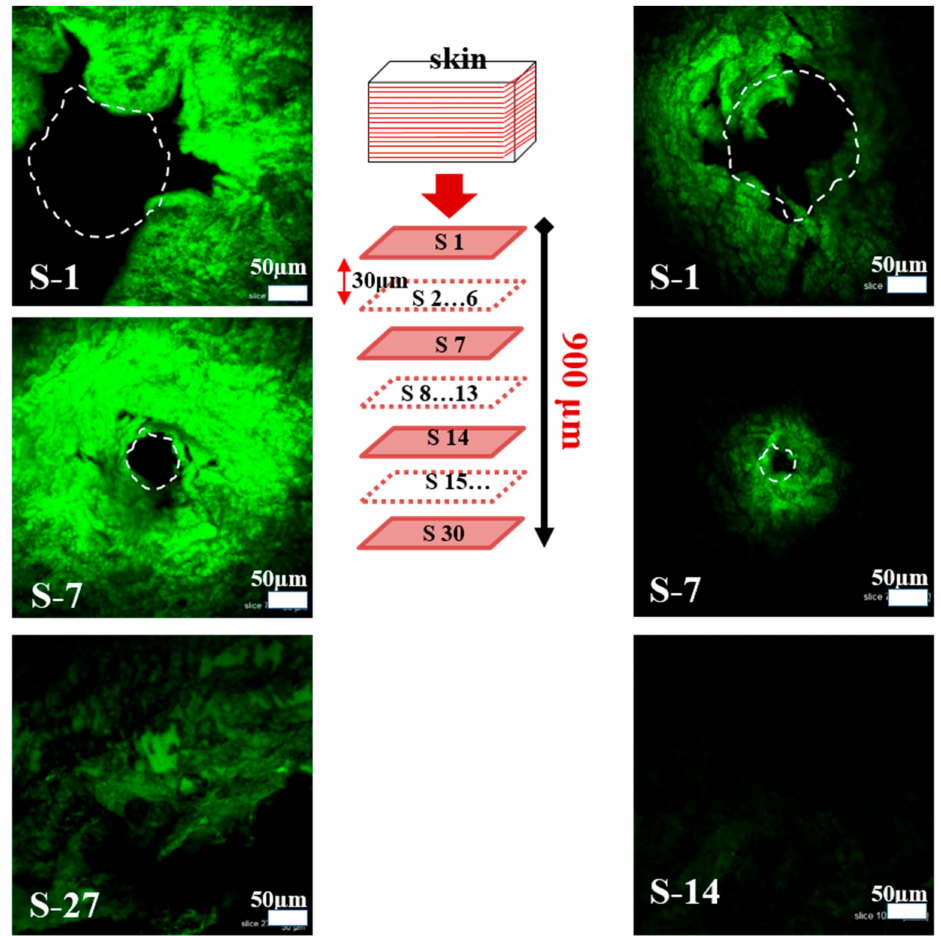
Figure 5. Confocal laser scanning micrographs of histological sections for calcein delivery in porcine skin at 37 ◦ C: left side, calcein delivered in skin at pH 5.5; right side, calcein delivered in skin at pH 7.4. Histological sections were obtained by slicing the calcein-delivered skin tissues using a microtome. S-1 and S-27 represent the top skin section and the deepest section where calcein was detected, respectively. The thickness of each section is 30 µ m (left side at pH 5.5). S-1 represents the top skin section, whereas S-14 represents the deepest section where calcein was detected (right side at pH